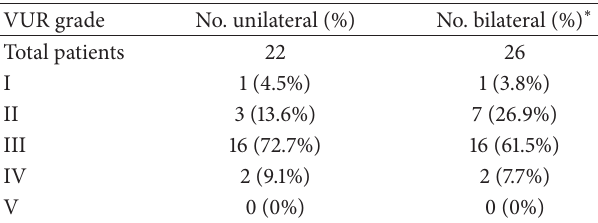
Table 2: Distribution of VUR